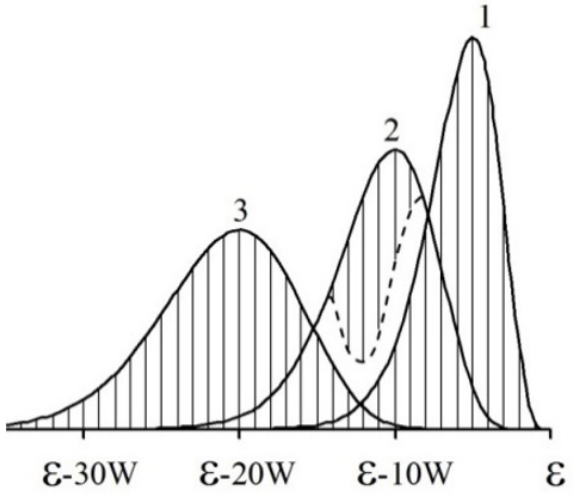
Fig. 3. Energy distributions of electrons traveled a path of 5λ (1), 10λ (2) and 20λ (3).